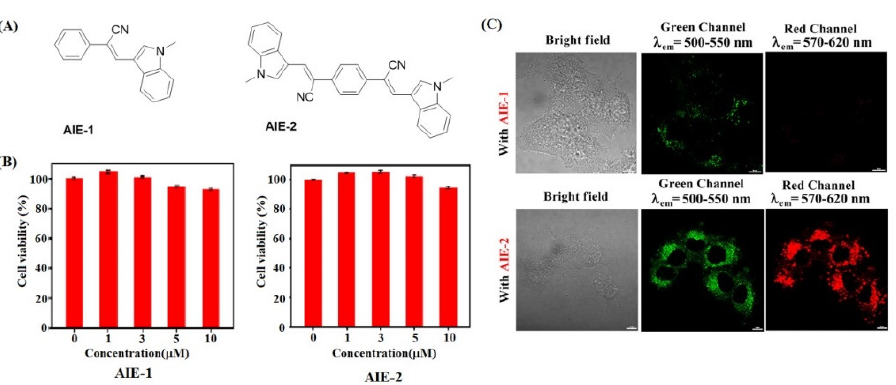
Figure 21. ( A ) Represents the structure of the AIE-1 and AIE-2 probes. ( B ) The plot demonstrates the cytotoxicity assay for HeLa cells incubated with AIE-1 and AIE-2 for 24 h. ( C ) Confocal fluorescence images were captured for HeLa cells incubated with AIE-1 and AIE-2 fluorescent probes. Reprinted from reference [100] with the permission of MDPI.